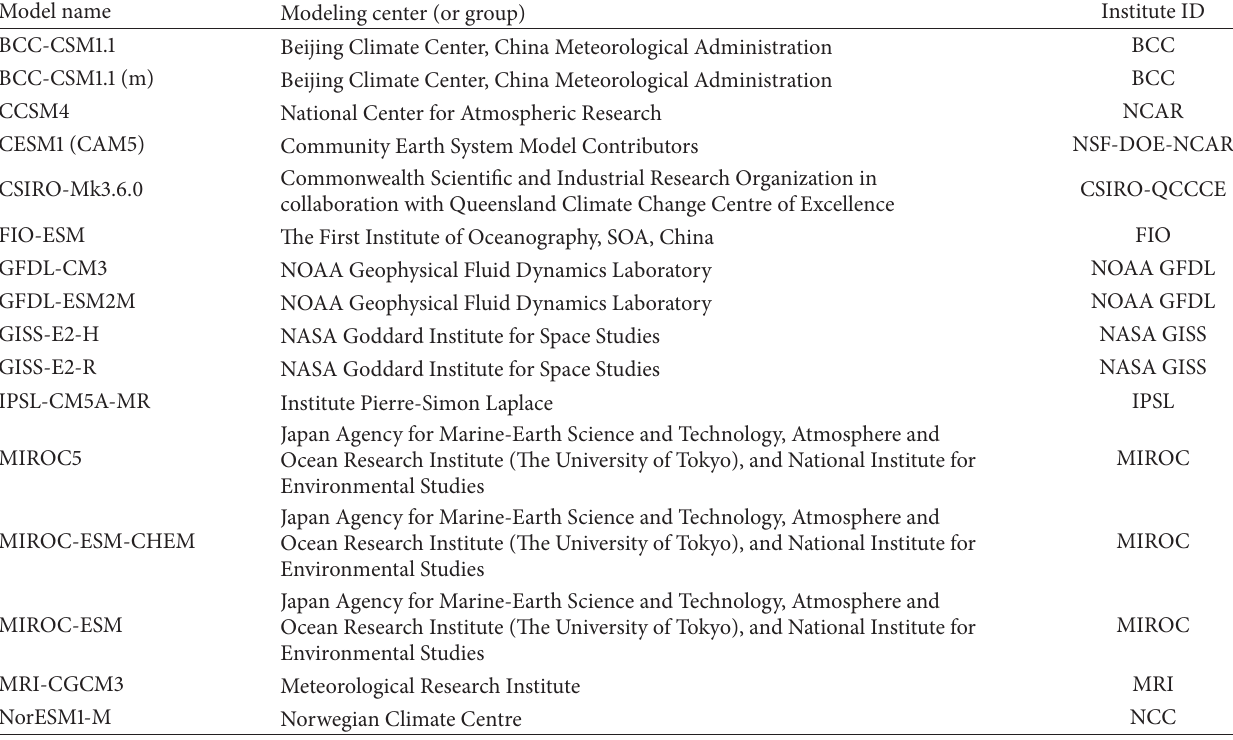
Table 3: List of models used for the